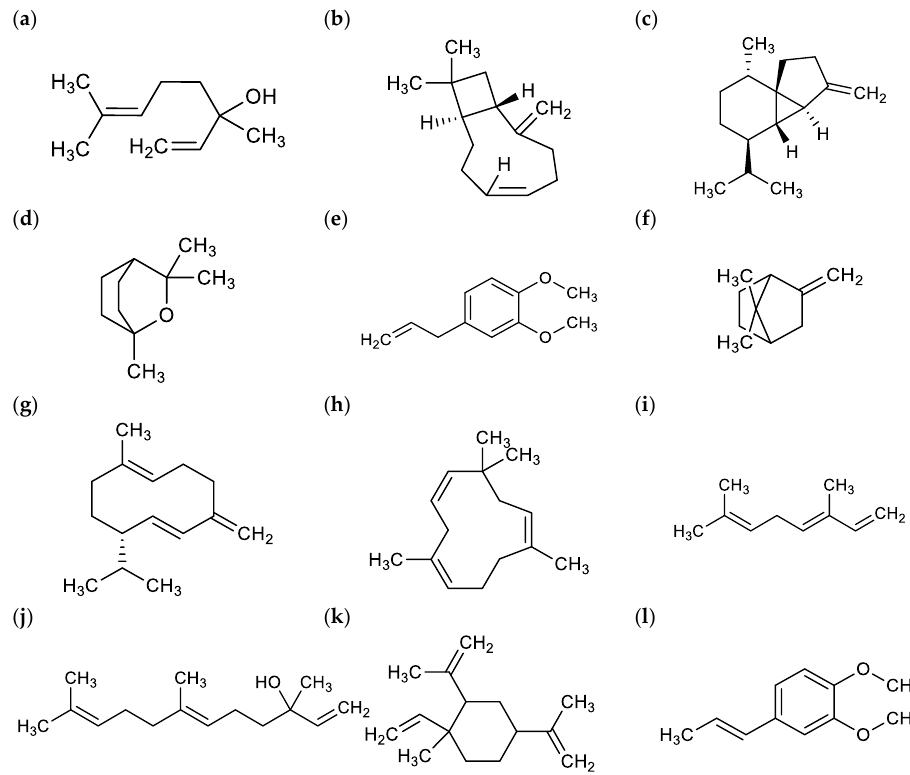
Figure 2. The main aroma constituents in the essential oil of flower, stem, and leaves of M. alba. ( a ) Linalool, ( b ) caryophyllene, ( c ) β -cubebene, ( d ) eucalyptol, ( e ) eugenol methyl ether, ( f ) α -fenchene, ( g ) germacrene D, ( h ) α -humulene, ( i ) (E)-ocimene, ( j ) nerolidol, ( k ) 2,4-diisopropenyl-1-methyl-1-vinylcyclohexane, ( l ) isoeugenyl methyl ether. [11,14 – 16]